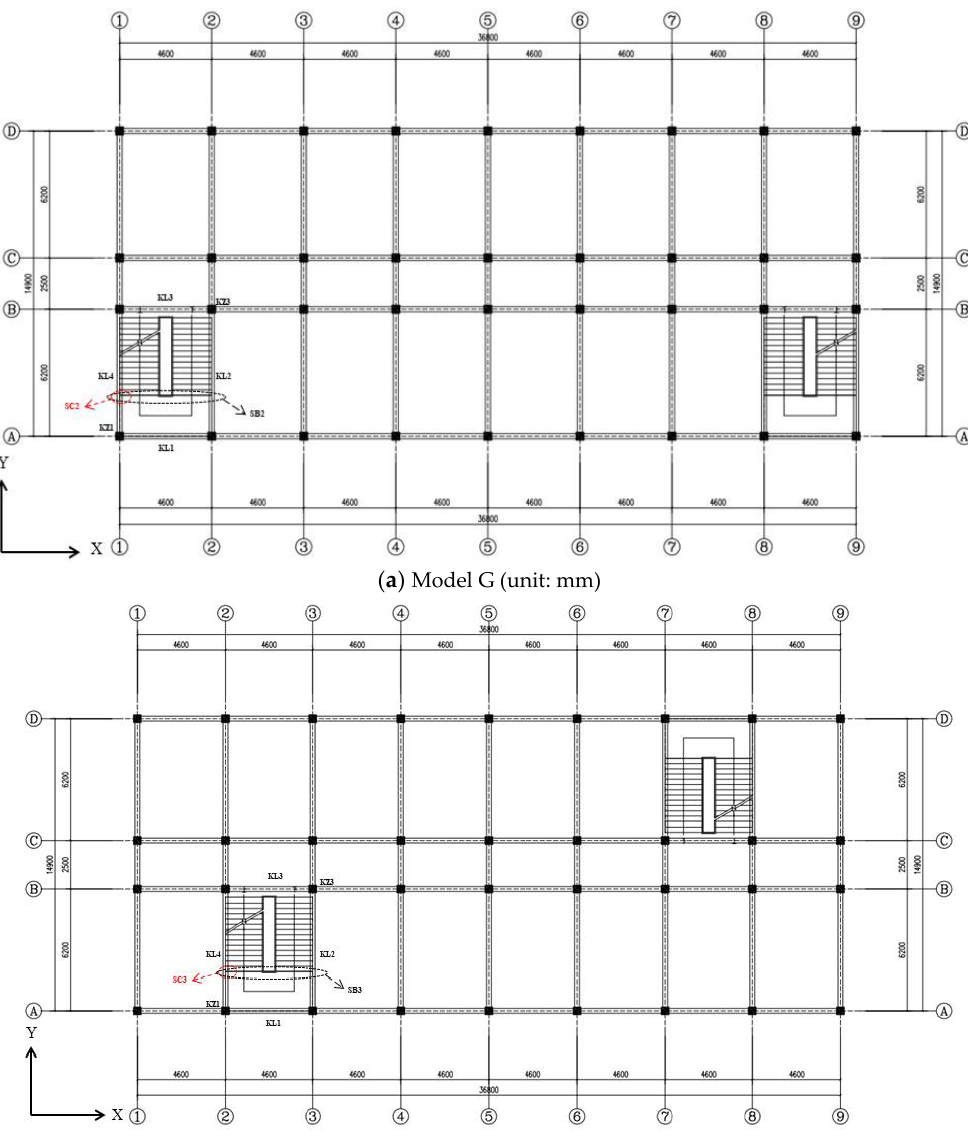
Figure 6. The layout plan of the models.